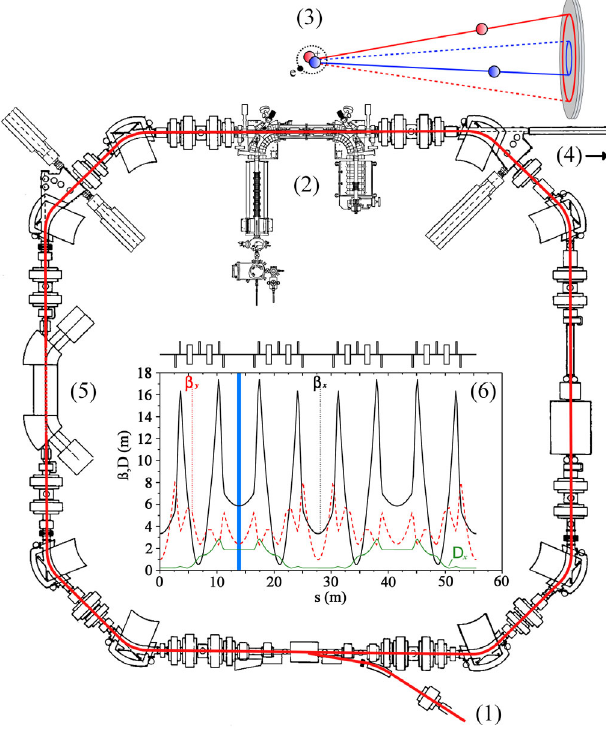
FIG. 1. Overview of the heavy-ion storage ring TSR: After injection from a linear accelerator (1, not shown), singly-charged molecular ions were electron-cooled in the photocathode Electron Target (2). Recombination (3) led to neutral products that left the ring via an extraction beam line and were recorded by a fragment- imaging detector (4, not shown). The primary electron cooler of TSR (5) is shown only schematically, as it is not discussed here. The inset (6) shows the beta ( β x and β y ) and horizontal dispersion ( D x ) functions of the TSR in standard operation mode [30]. The solid blue line in the graph indicates the position of the Electron